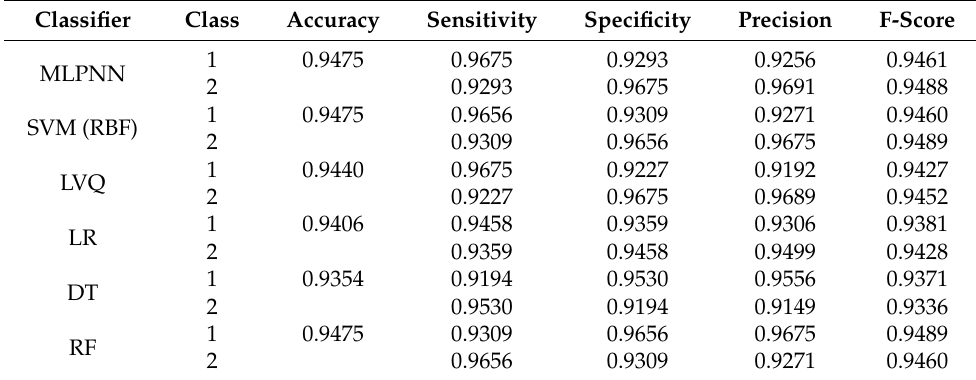
Table 2. Classification results for RF selected set of